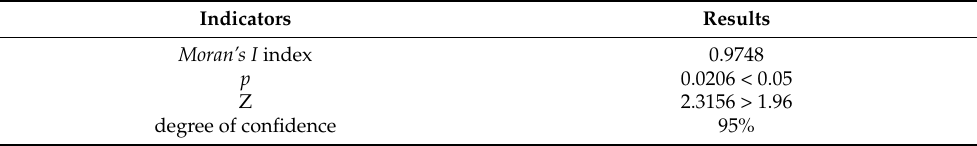
Table 2. Global Autocorrelation Analysis Data of Warehouse Supermarkets in Liaoning